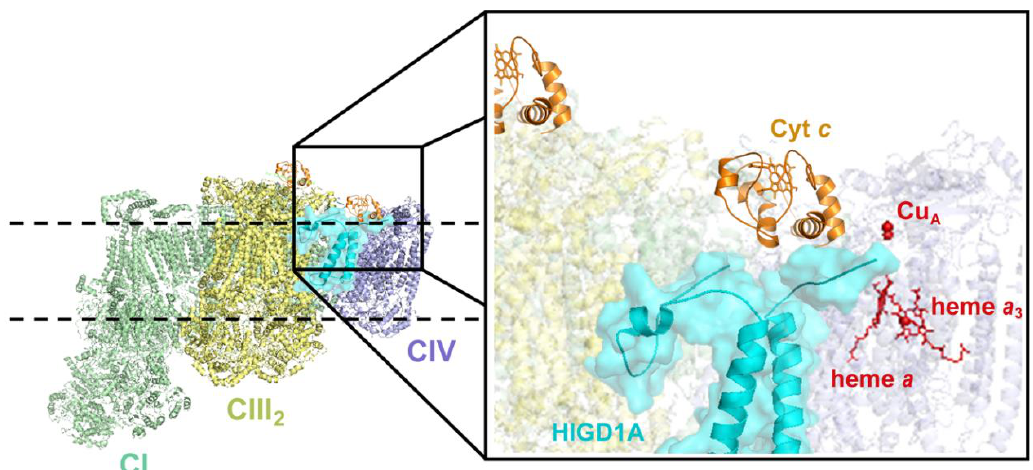
Figure 4. HIGD1A interacts with CIV and enhances its activity. Following a proposed model [31,70], overexpressed HIGD1A interacts with cytochrome c and CIV and produces a structural change in the CIV heme a active center, acting as a positive modulator of the enzyme. The figure was generated with PyMOL and Adobe Photoshop using the structure of the CI-CIII 2 -CIV respirasome from ovine ( Ovis aries ) heart mitochondria [81](PDB 5J4Z). IMS, intermembrane space. IMM, inner mitochondrial